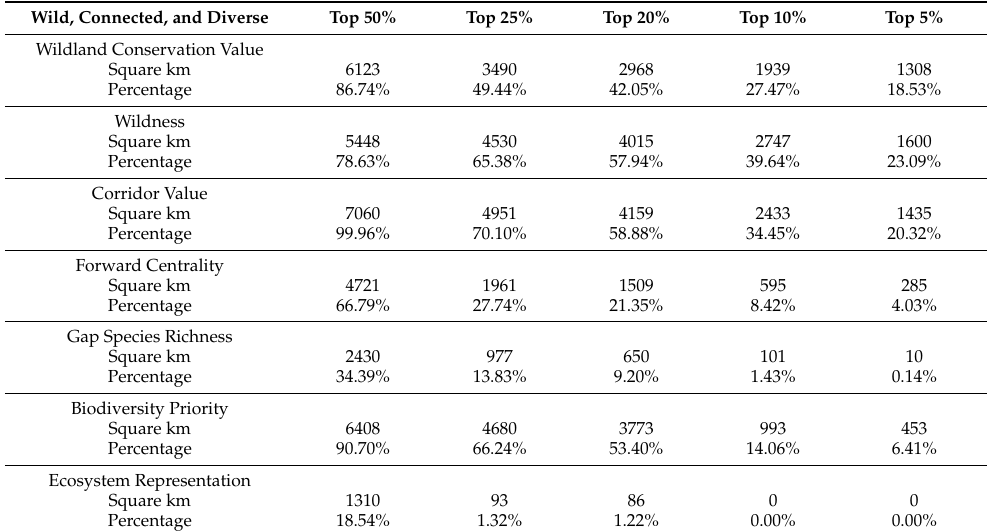
Table 2. The conservation values of the Pacific Crest Trail corridor. Wild, Connected, and